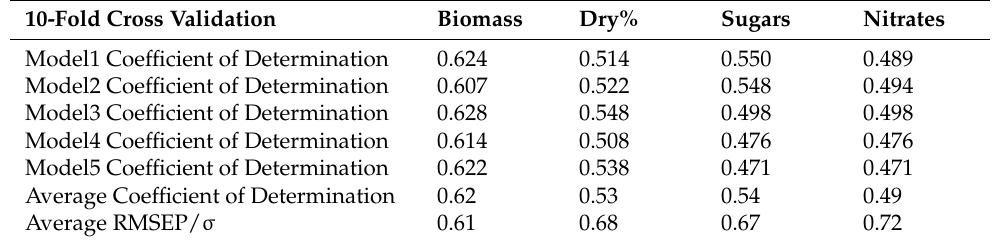
Table 2. Model metrics for each target